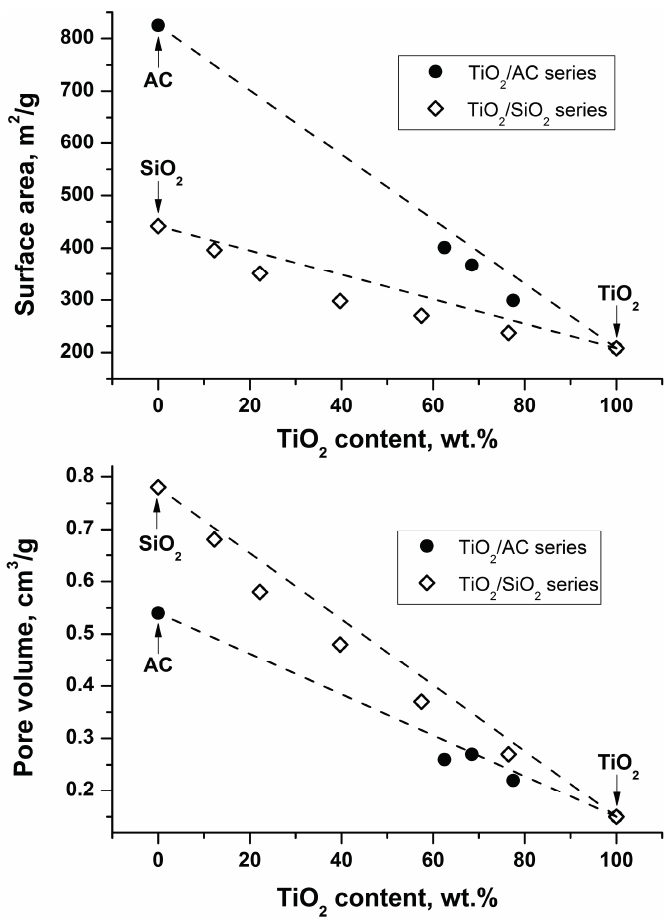
Figure 1. Dependences of the specific surface area and pore volume on TiO 2 content for the TiO 2 /AC and TiO 2 /SiO 2 composite photocatalysts.